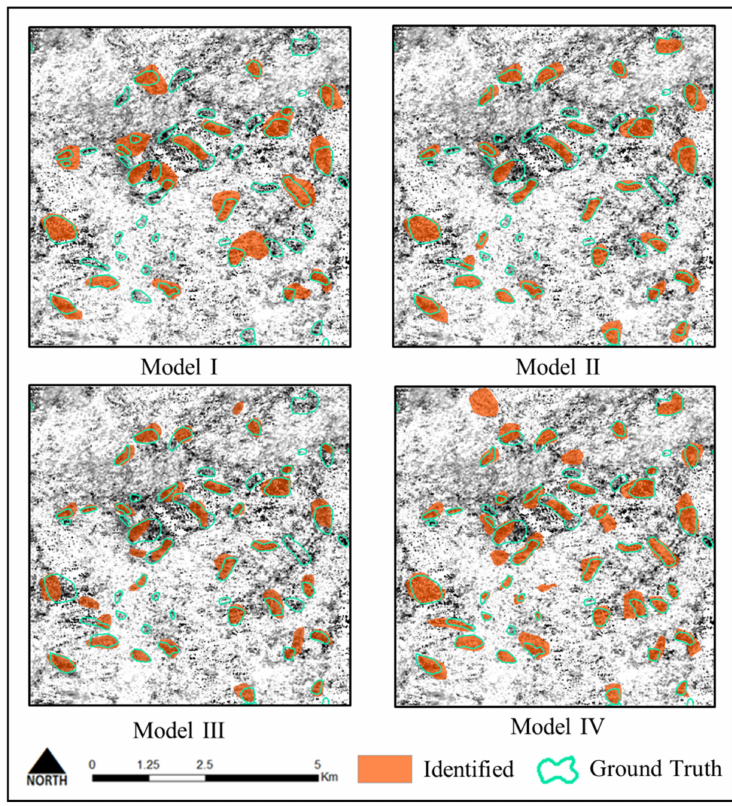
Figure 22. Comparison of different modules in test area